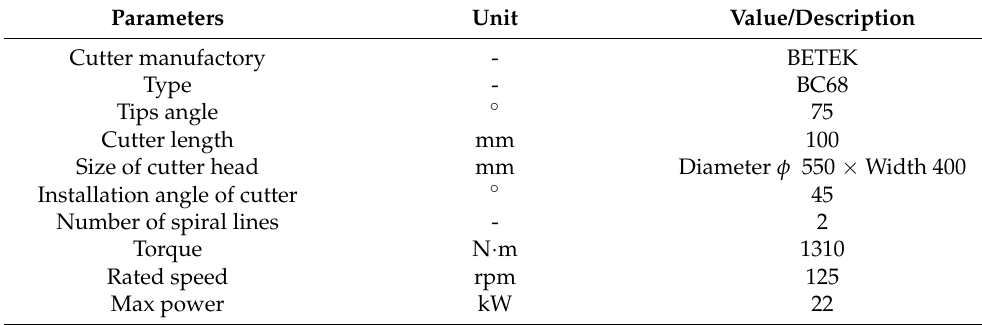
Table 5. Cutter head